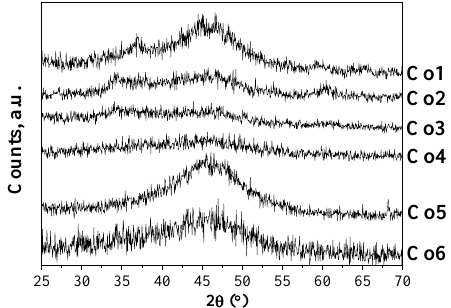
Figure 3. X-ray diffraction patterns of Co1 – 6 NPs.